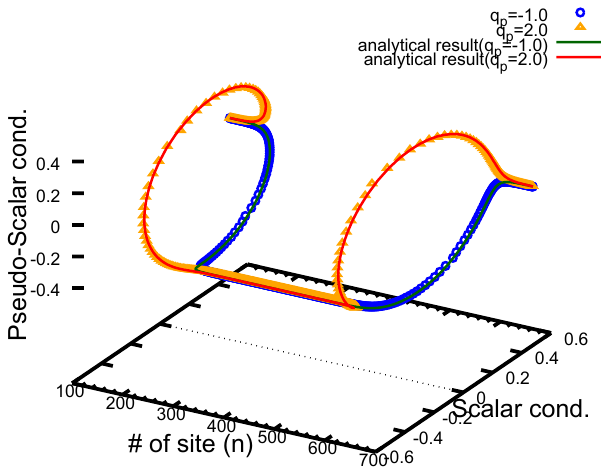
Figure 8 . Position dependence of the local scalar and pseudo-scalar condensates for N = 801 , a = 0 . 05 , m = 0 , θ = 0 in the presence of the probe charges at n = 200 and 600 . We drop the data at n < 100 and 700 ≤ n as we are not interested in boundaries. The circle (blue) and triangle (yellow) symbols denote the probe chargers q p = − 1 . 0 and q p = 2 . 0 , respectively.